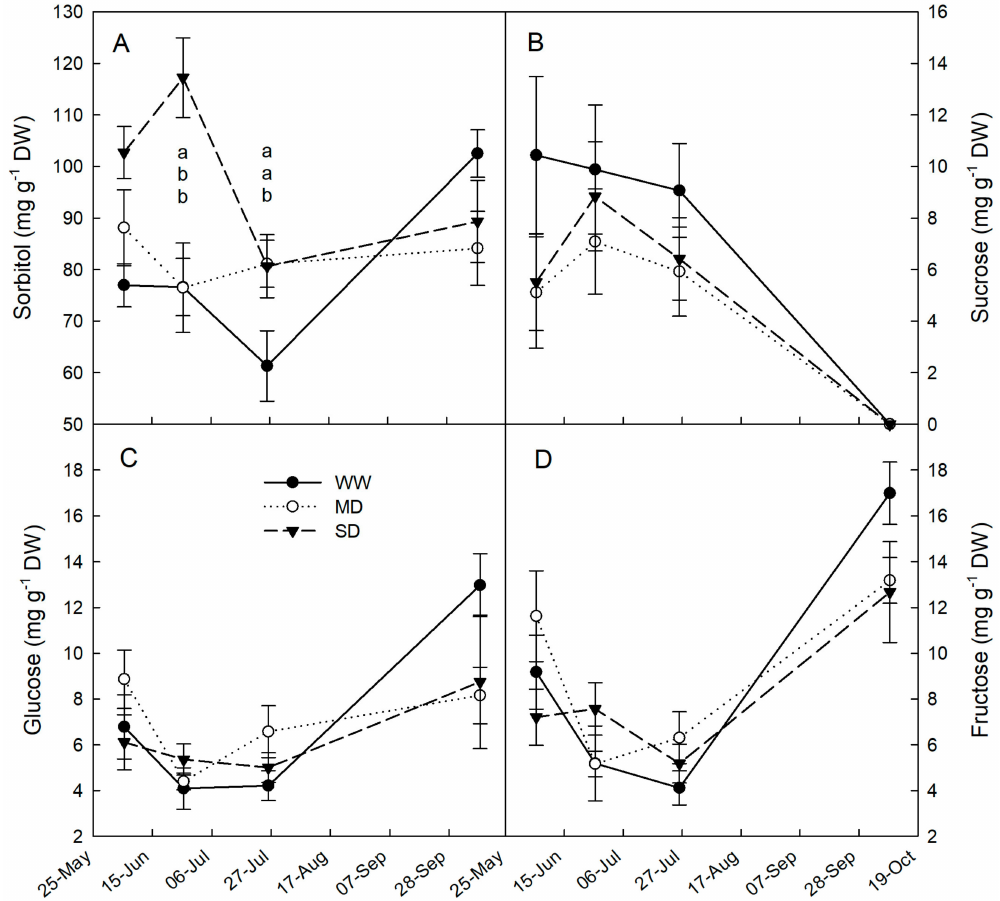
Figure 4. ( A ) Sorbitol, ( B ) sucrose, ( C ) glucose, and ( D ) fructose content in leaves of loquat plants under well-watered conditions (WW), mild drought (MD), and severe drought (SD) during the four months of drought. Error bars represent standard errors of means. When present, di ff erent letters indicate significant di ff erences among drought treatments for a specific date (Tukey’s multiple range test, p <